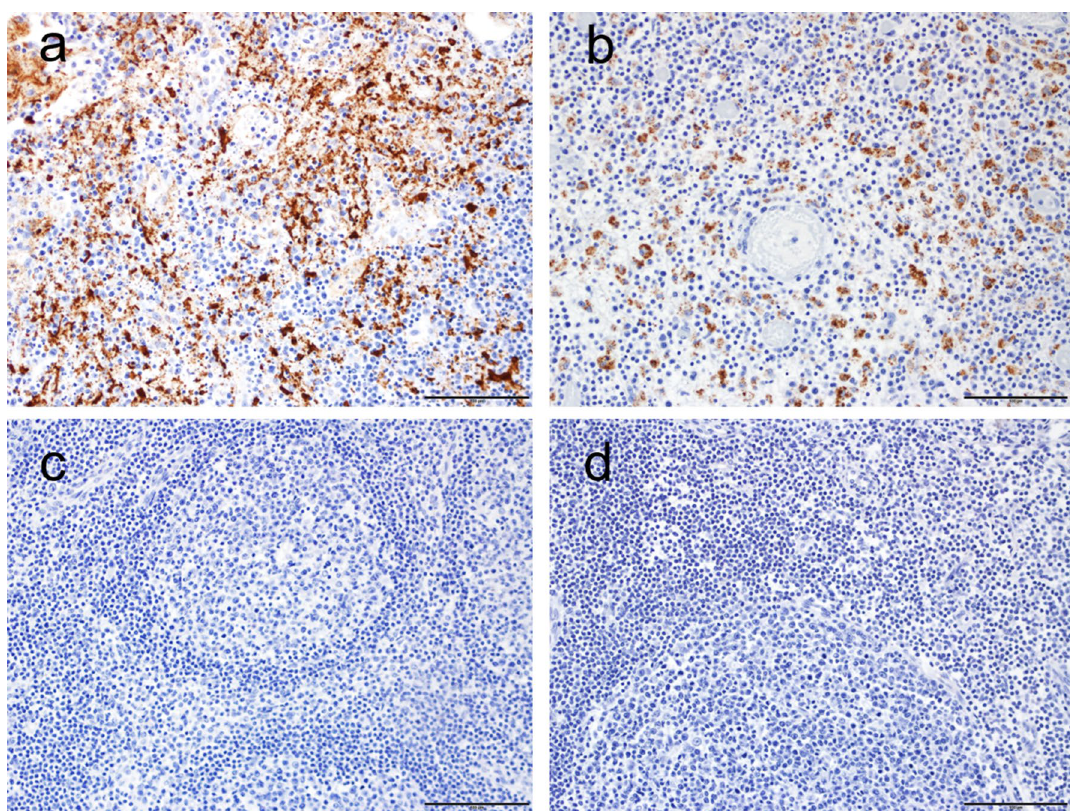
Figure 6. IHC staining of tracheobronchial lymph nodes . ( a ) Lymph node from an untreated nonsurviving NHP (100× magnification). Positive staining (brown) for EBOV viral antigen is shown. ( b ) Lymph node from a remdesivir-treated nonsurvivor (100× magnification). ( c ) Lymph node from an untreated survivor (100× magnification). No positive staining for EBOV antigens is shown. ( d ) Lymph node from a treated survivor (100× magnification). No positive staining for EBOV antigen is